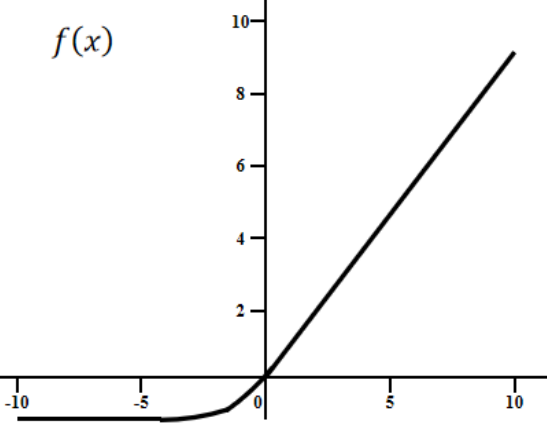
Figure 13. The curves of ELU function.